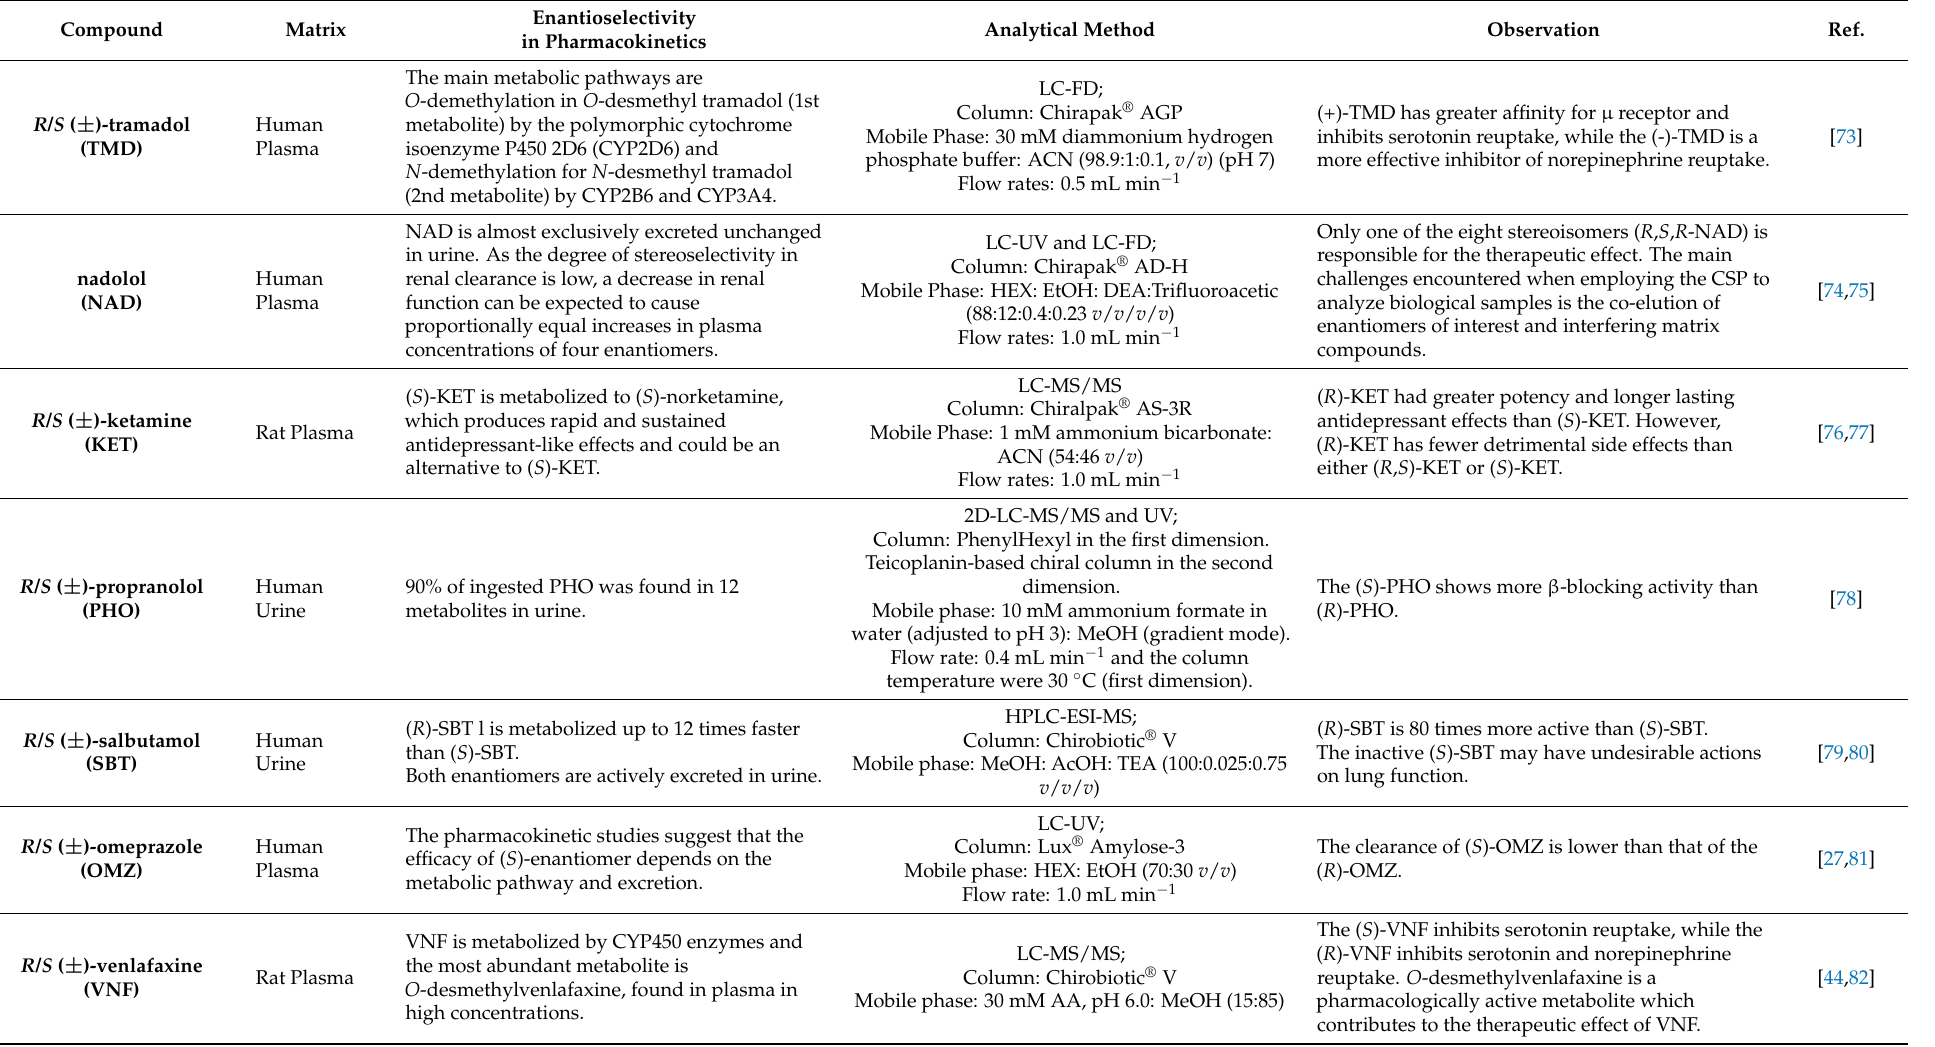
Analytical Method